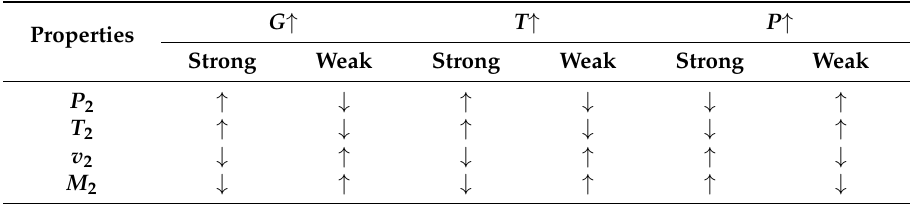
Table 5. Effects of initial conditions to the burned